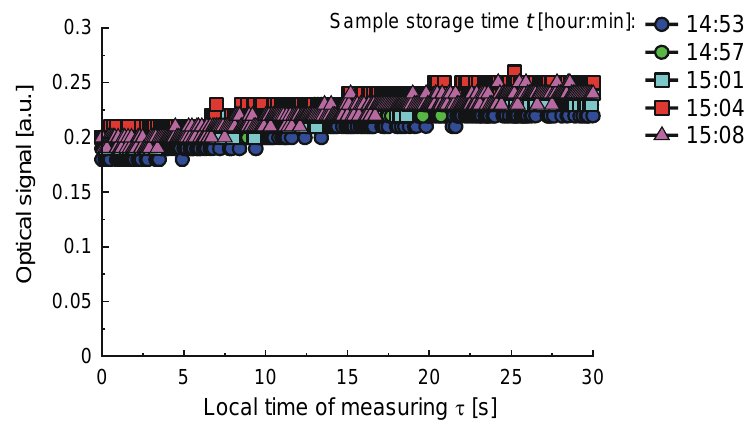
Figure 19. Signals from milk samples stored for about 15